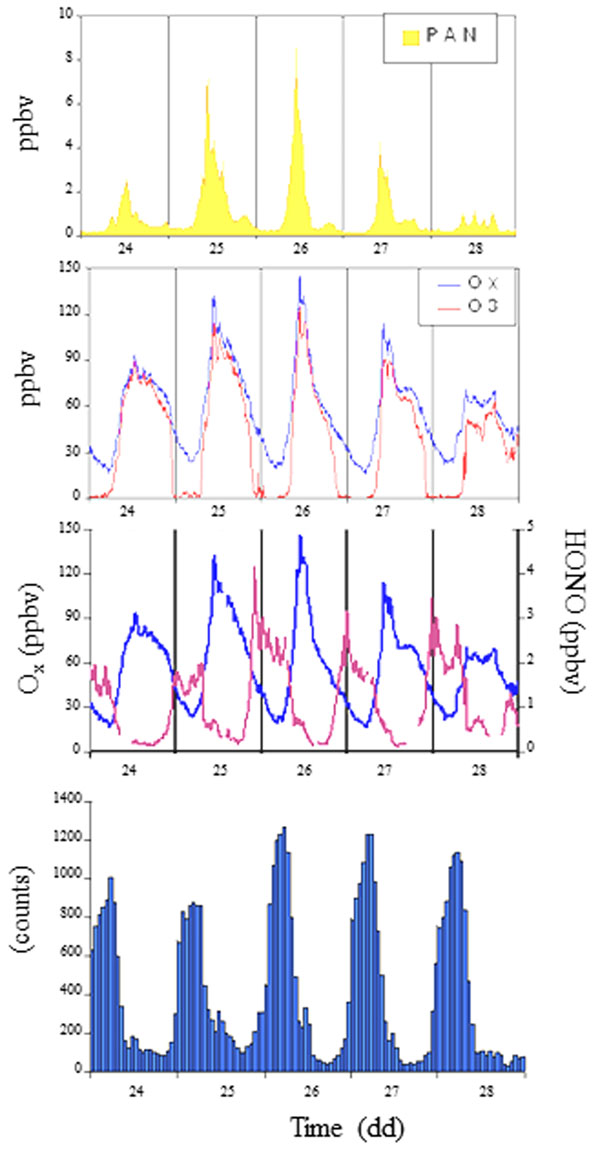
a) Typical trends of PAN, Ox and O3 during a summer period (June, 24th-28th) in relationship with the radon concentration behavior; b) trends of HNO2 and Ox during photochemical activity in summer period.